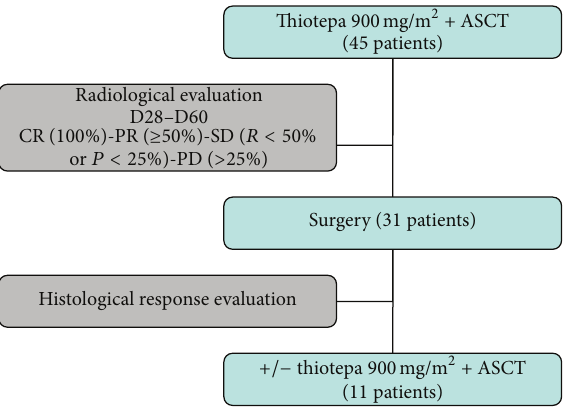
Figure 1: Treatment